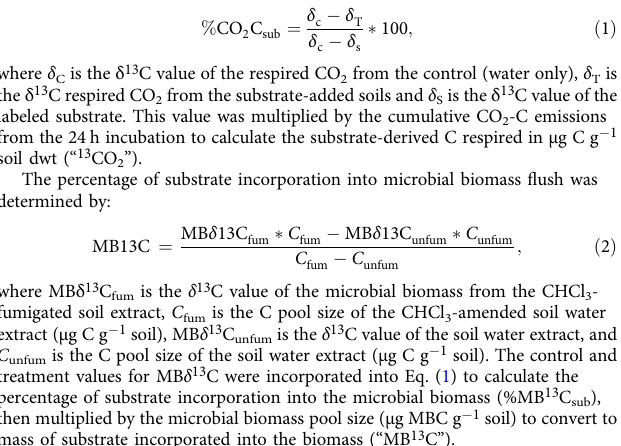
where δ C is the δ 13 C value of the respired CO 2 from the control (water only), δ T is the δ 13 C respired CO 2 from the substrate-added soils and δ S is the δ 13 C value of the labeled substrate. This value was multiplied by the cumulative CO 2 -C emissions from the 24h incubation to calculate the substrate-derived C respired in μ g C g − 1 soil dwt ( “ 13 CO 2 ” ). The percentage of substrate incorporation into microbial biomass fl ush was determined by: